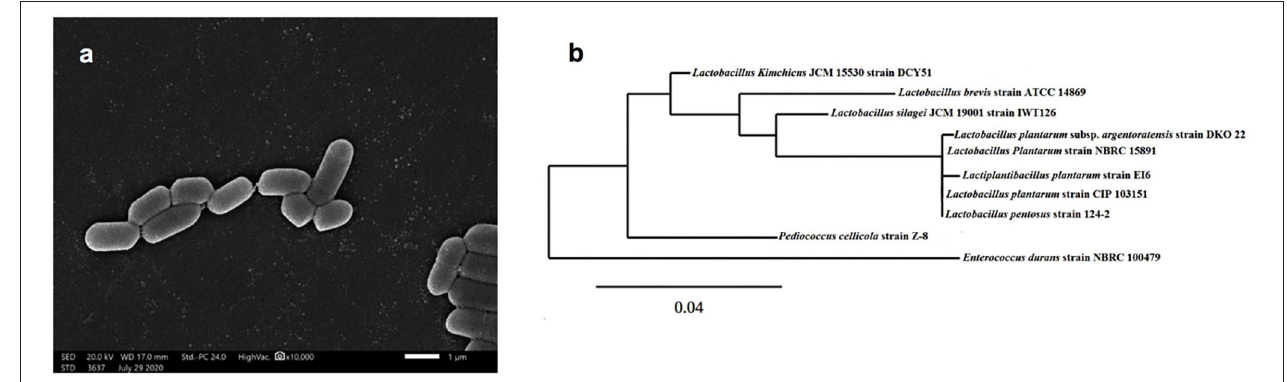
FIGURE 1 | Scanning electron microscope of isolate EI6 (A) , and phylogenetic analysis of the marine isolate Lactiplantibacillus plantarum EI6 based on 16s rRNA gene sequence (B) .